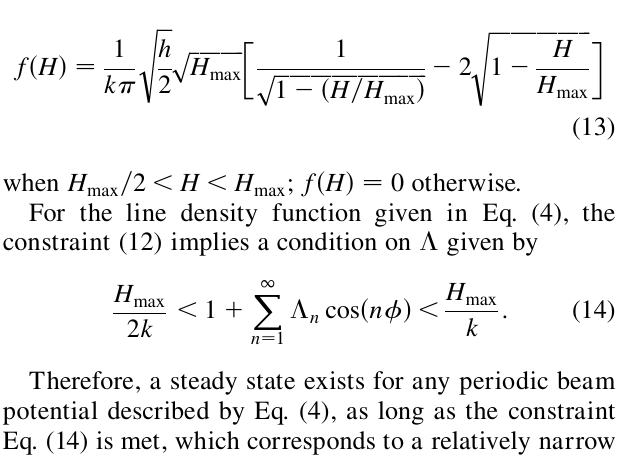
FIG. 11. (Color) (a) The steady-state Hamiltonian surface for the line density specified in Eq. (15). (b) The associated steady- state distribution function. In both plots, the blue color indi- cates the lowest values and the red color indicates the highest